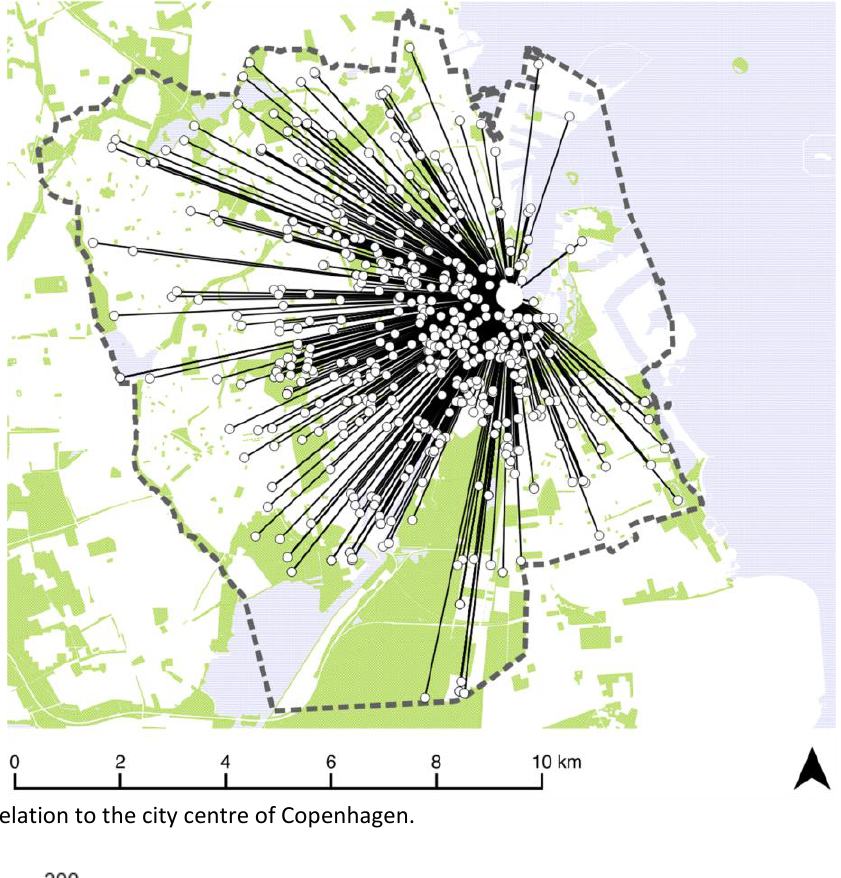
Figure 7. Images' relation to the city centre of Copenhagen.